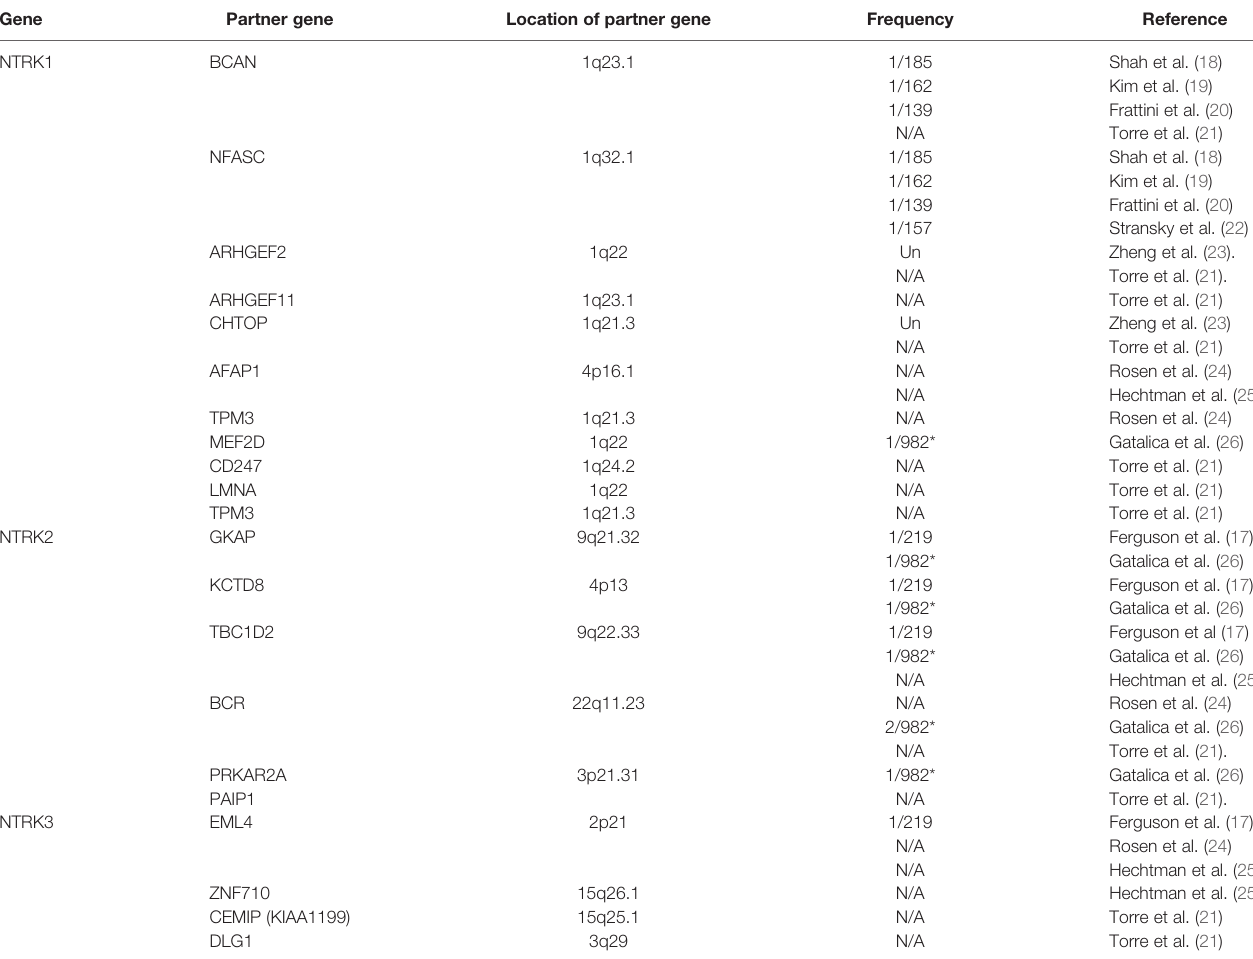
TABLE 1 | NTRK fusions identi fi ed in